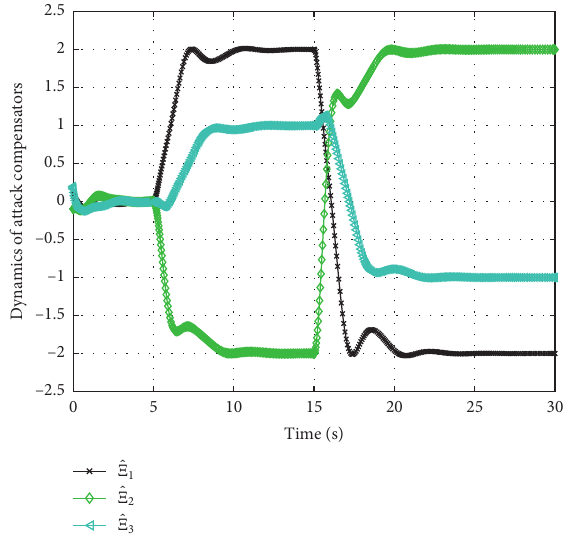
Figure 4: System states without the attack compensator.